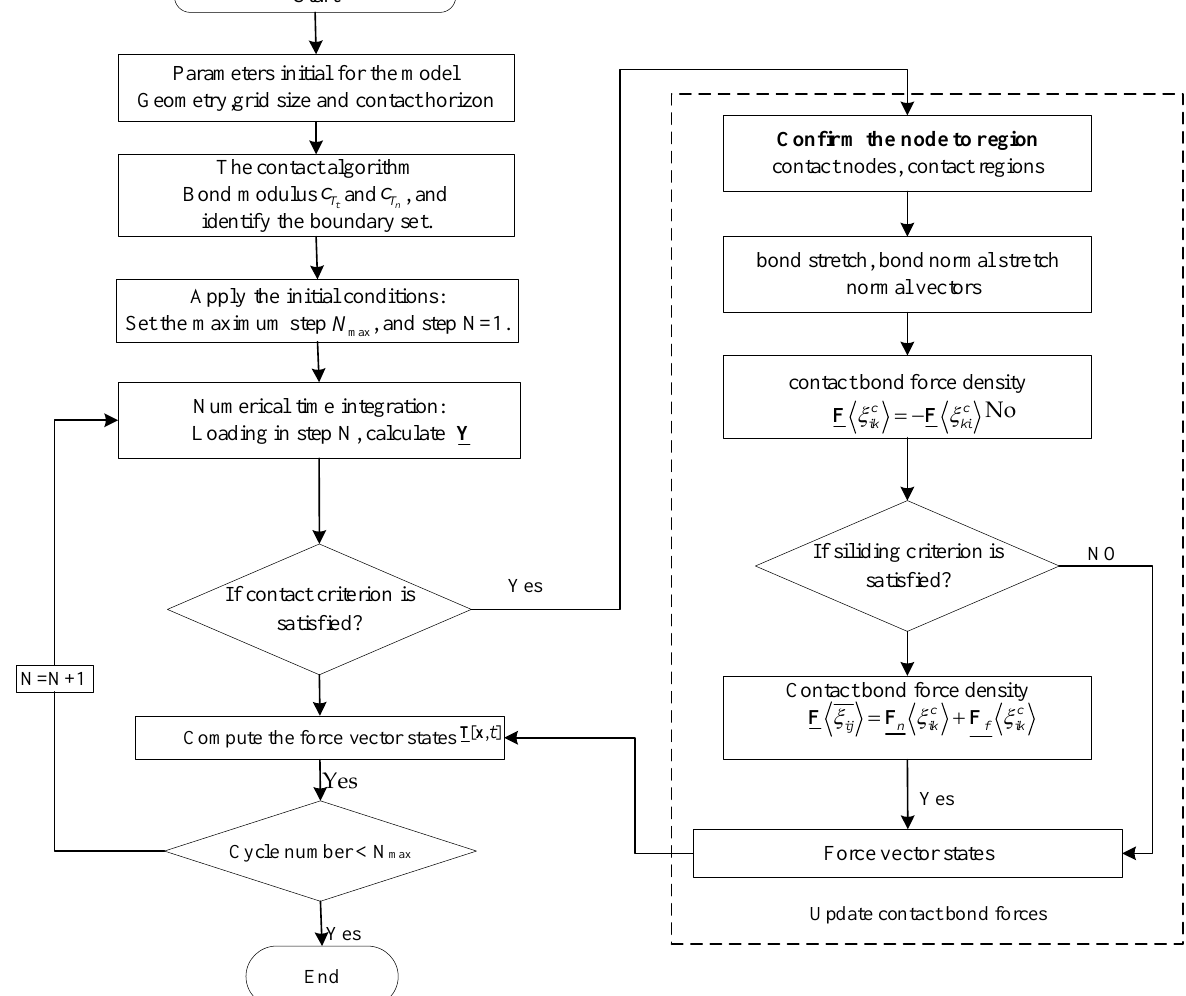
Figure 5. The flowchart of the nonlocal peridynamic contact algorithm.